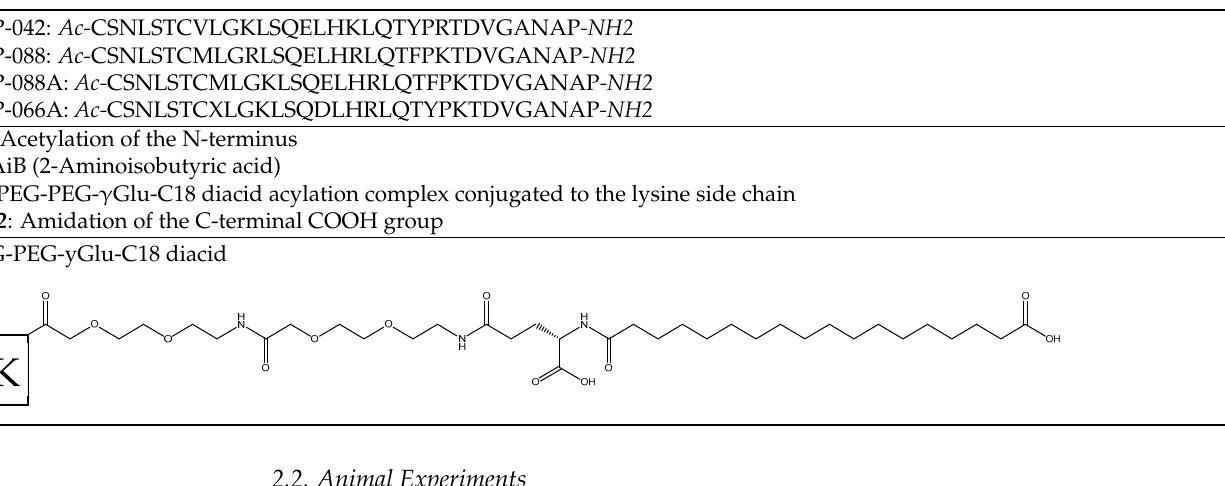
Table 1. Amino acid sequence of KBP-042, KBP-088, KBP-088A, and KBP-066A. The peptides consist of an NH 2 -terminal acetyl group (Ac), and a COOH-terminal amide group. KBP-088A and -066A have an additional acylation conjugated to the lysine (shown in bold). The chemical structure of the acylation is shown at the bottom of the table.